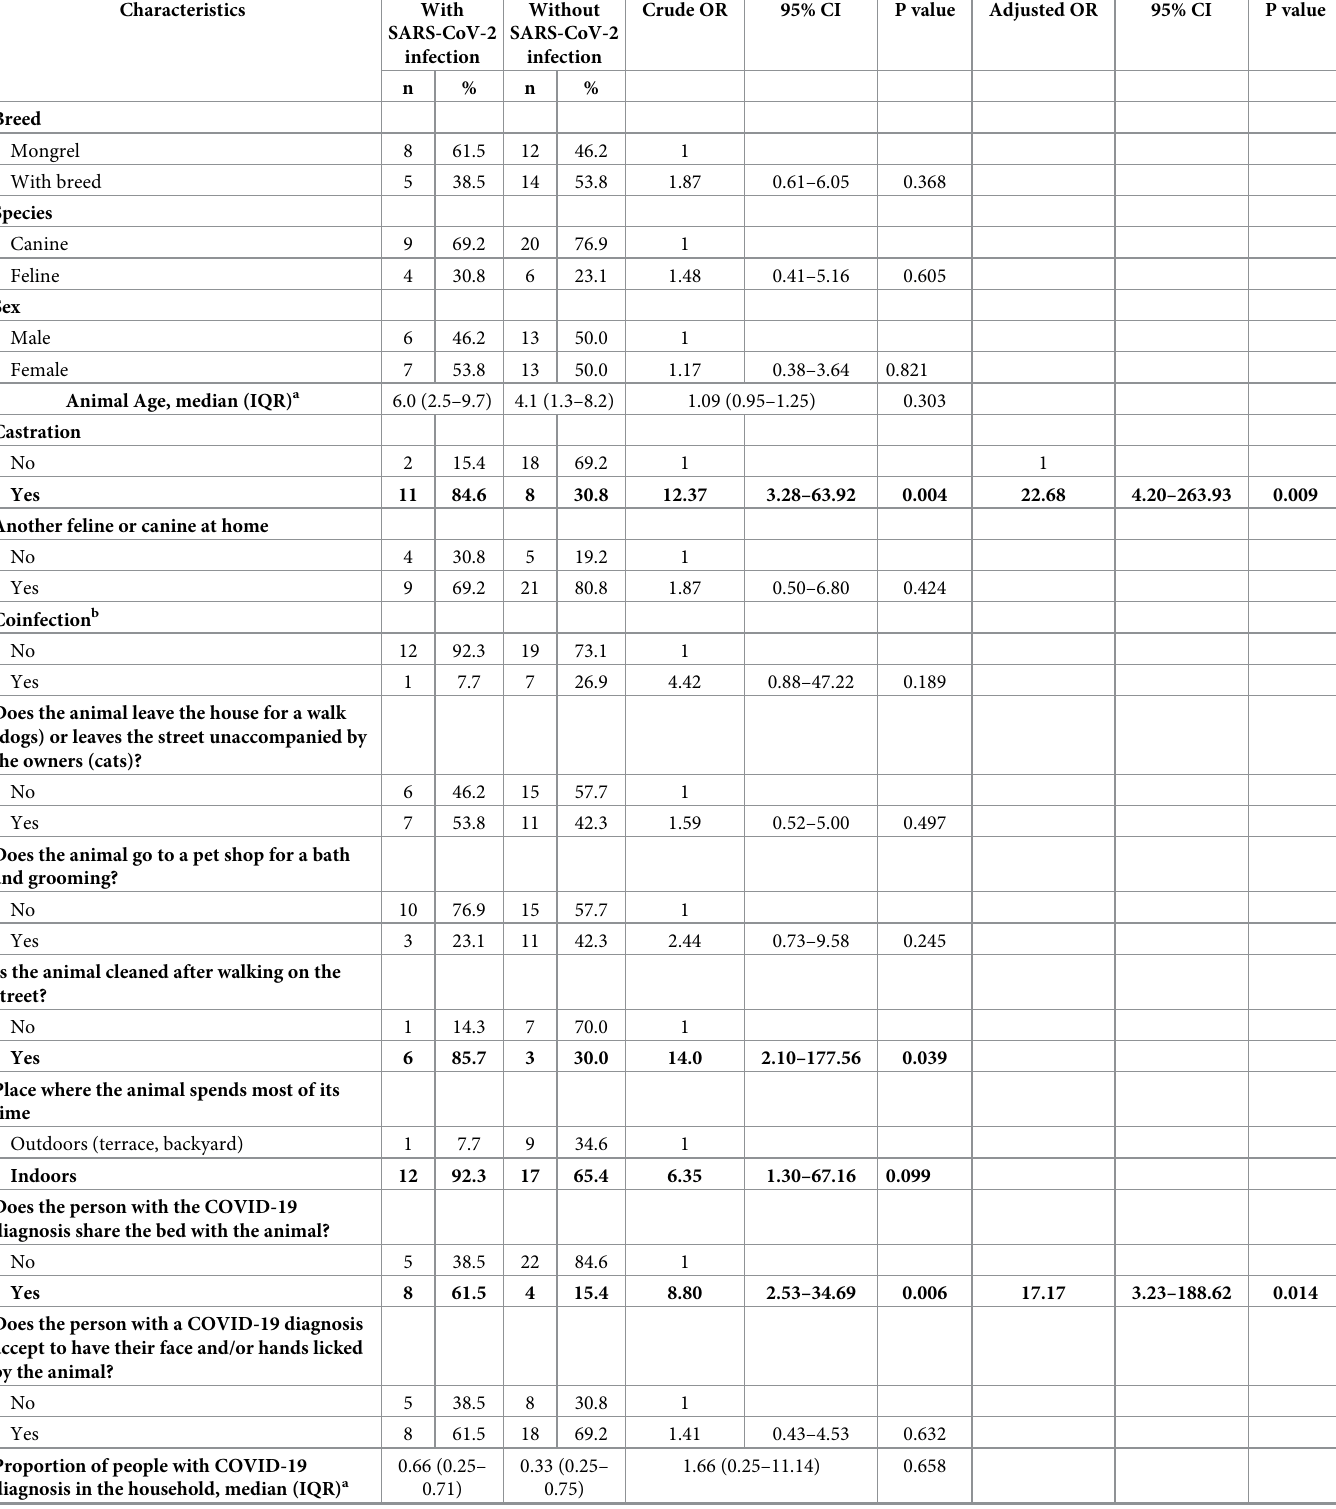
Table 4. Unadjusted and adjusted odds ratios for factors associated with animal SARS-CoV-2 infection, between May 2 nd , 2020 and October 7 th , 2020 (metropolitan region of the state of Rio de Janeiro, Brazil), (n = 39).